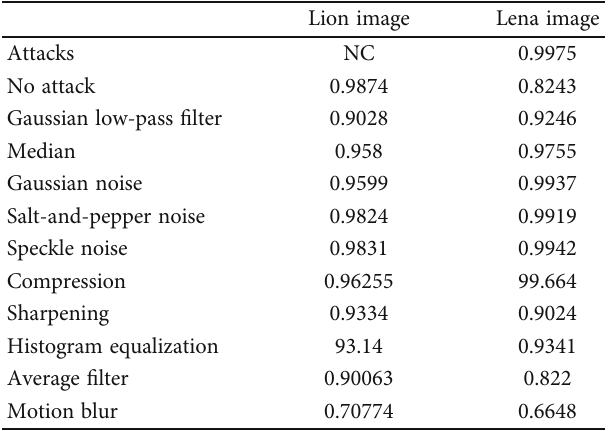
Table 2: Performance of the DWT-SVD method to identify robustness and quality of watermarked